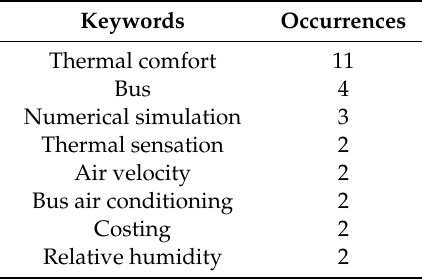
Table 5. Top 10 of the most relevant keywords of thermal comfort studies in bus cabin environments.